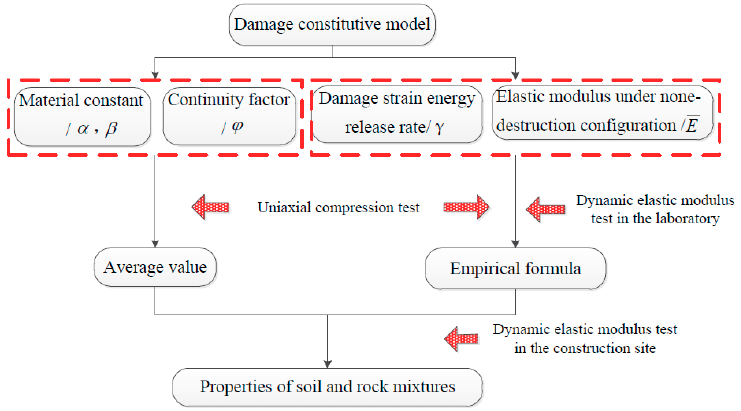
Figure 14. Technical process.